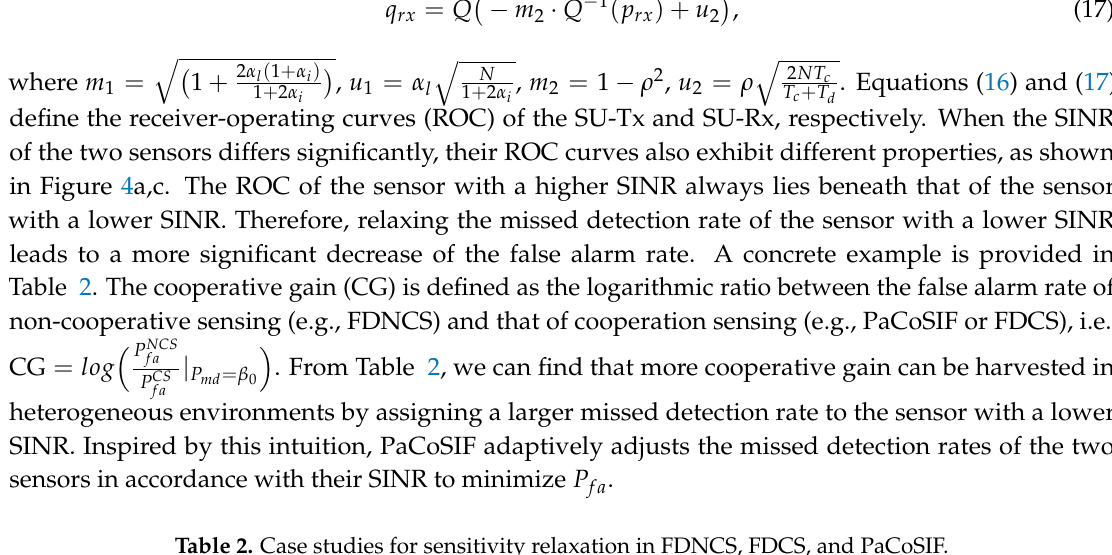
Table 2. Case studies for sensitivity relaxation in FDNCS, FDCS, and PaCoSIF.